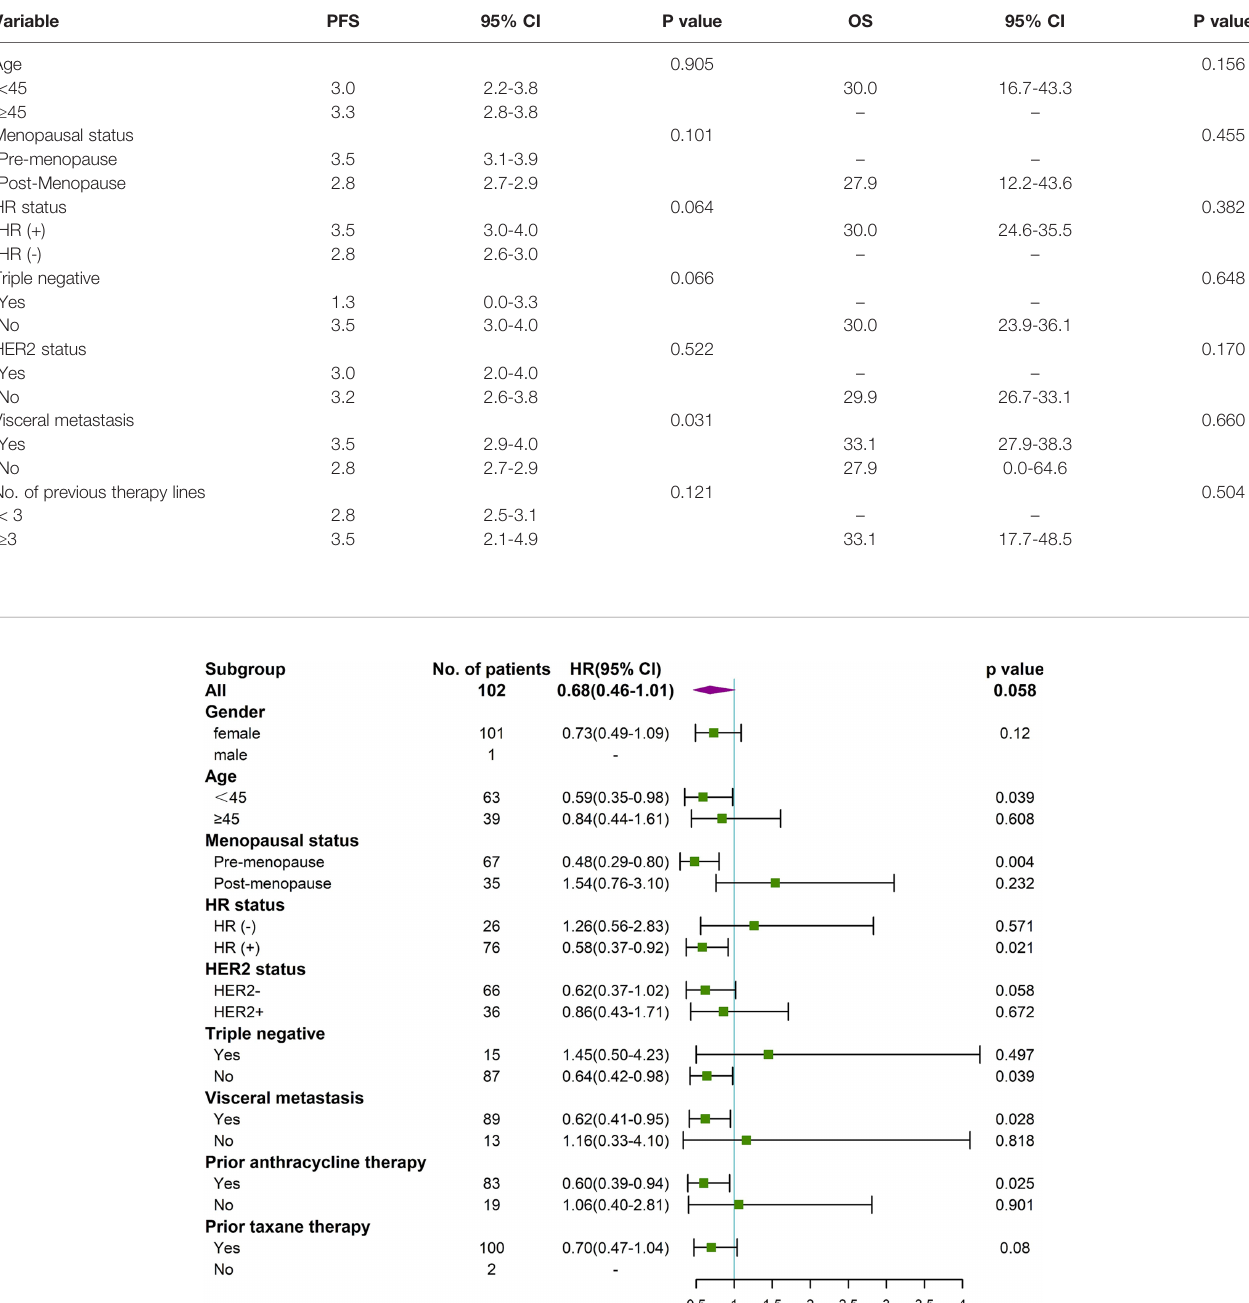
TABLE 3 | Univariate analysis of PFS and OS (Kaplan-Meier).